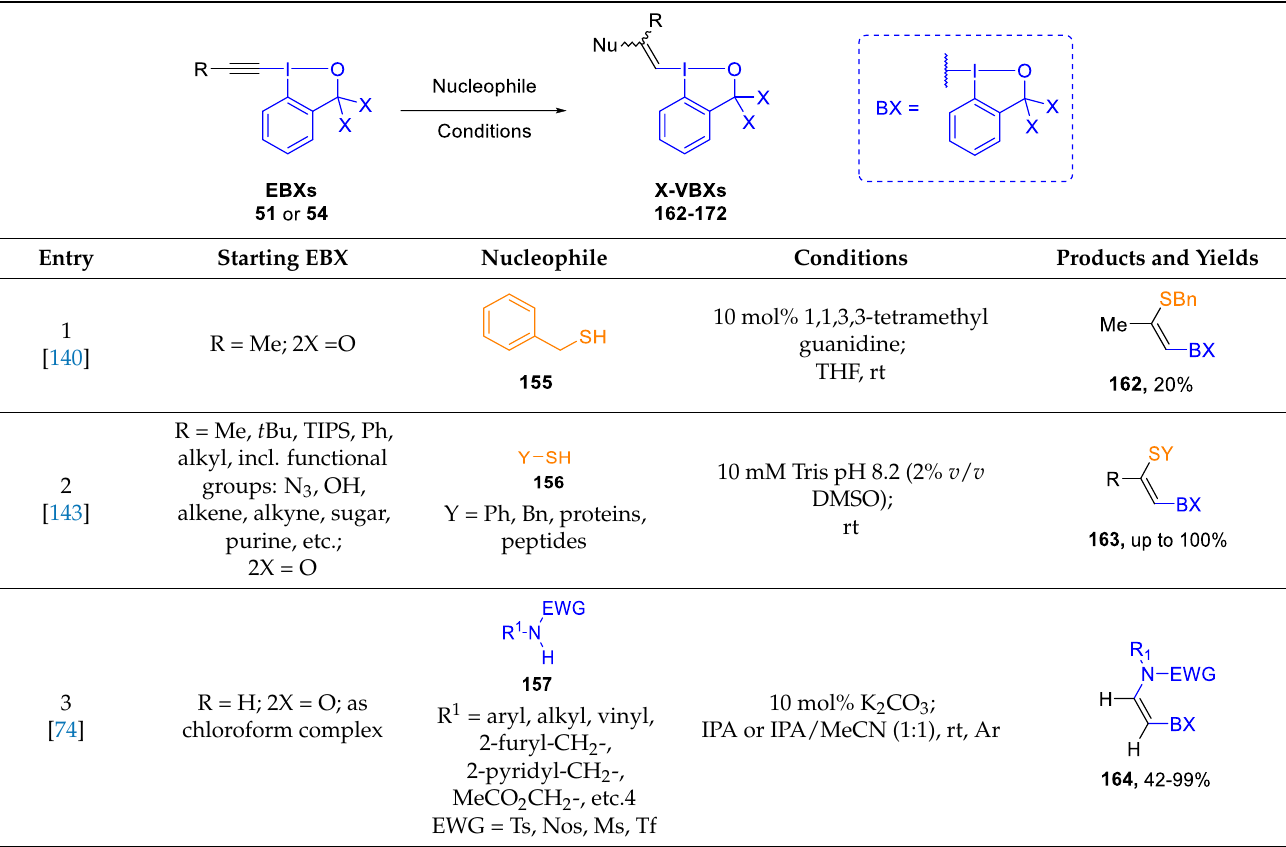
Table 1. Preparation of X-VBX [74,140,143,153,167–170,176].